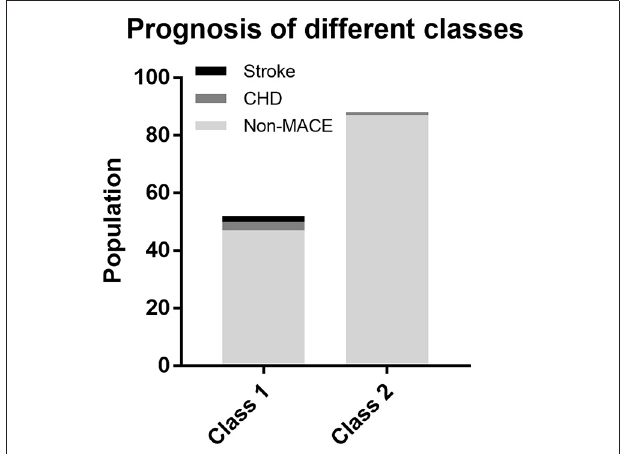
FIGURE 3 | Composition of outcome at 48 months follow-up by different classes.